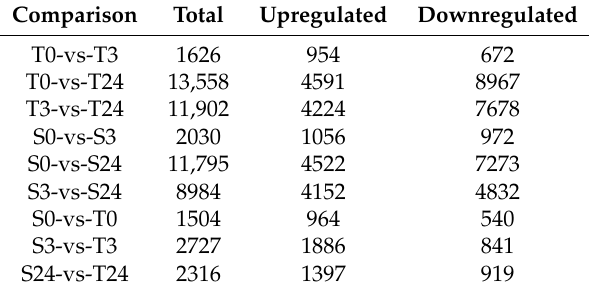
Table 2. The number of differentially expressed genes within and between H559 and YM21 during chilling stress.